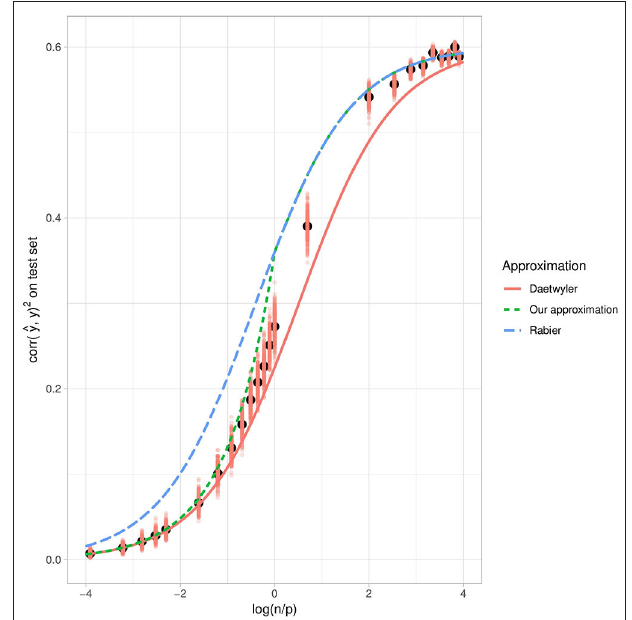
FIGURE 7 | Mean squared correlation between the phenotype and its prediction on the test set with respect to log( n ), using simulated data with p h 2 = 0.6. The salmon points correspond to the evaluation of the squared correlation and the black points correspond to the mean expectation for each value of log( n ) over 300 repetitions. Red dots correspond to training set p replications. The red plain curve corresponds to Daetwyler’s approximation for h 2 = 0.6, while the blue dashed curve corresponds to Rabier’s approximation and the green dotted curve corresponds to ours.